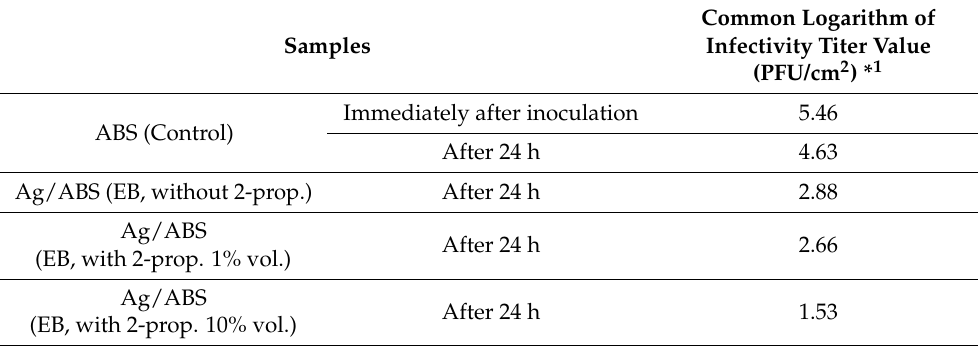
Table 4. Antiviral activity of Ag/ABS samples prepared by electron beam against Influenza-A virus.